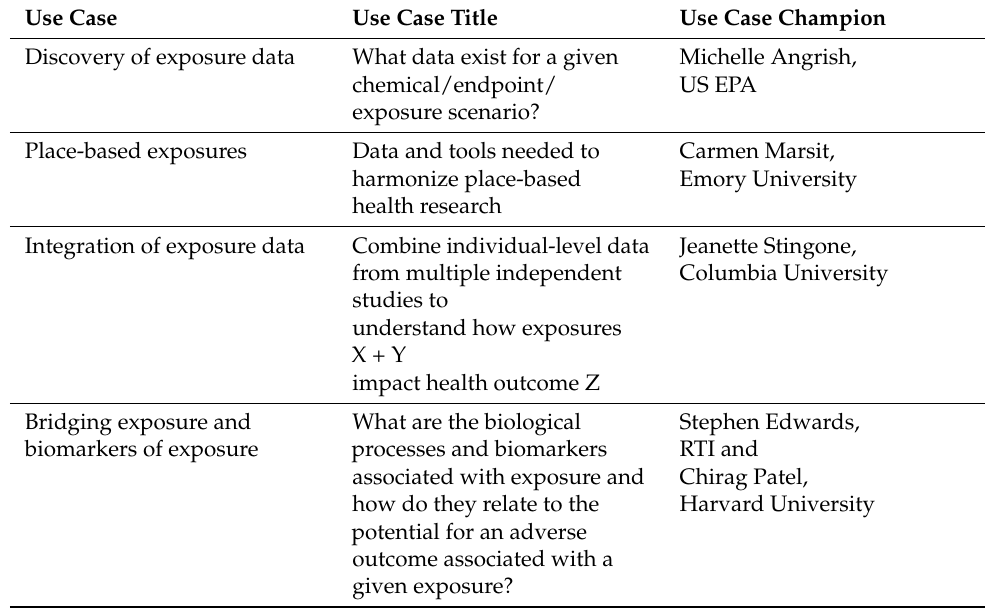
Table 1. Developing sustainable language solutions: Use